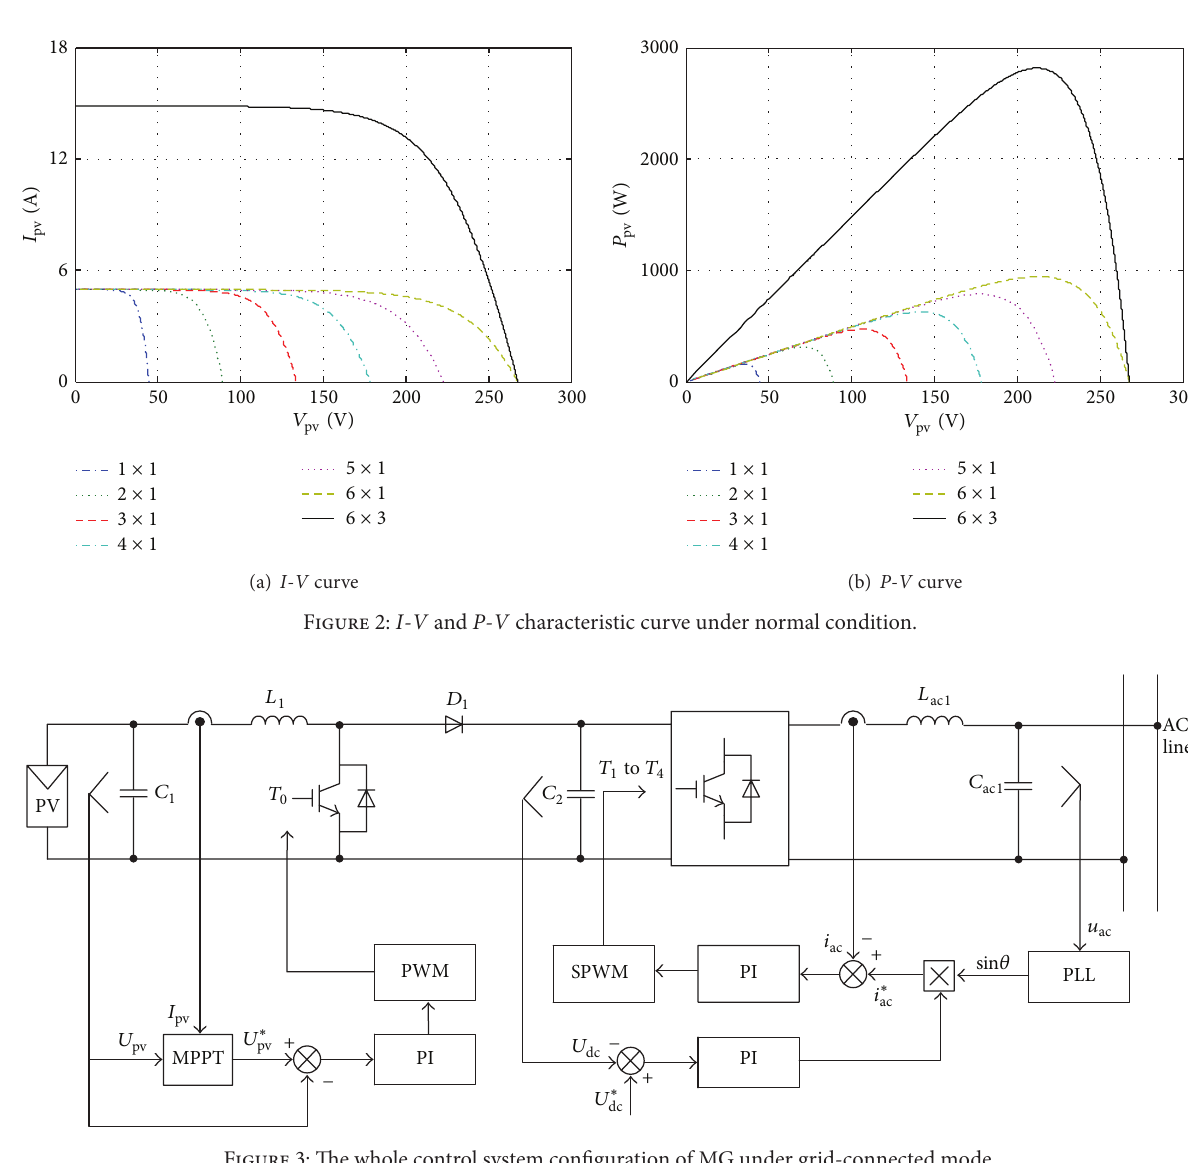
Figure 3: The whole control system configuration of MG under grid-connected